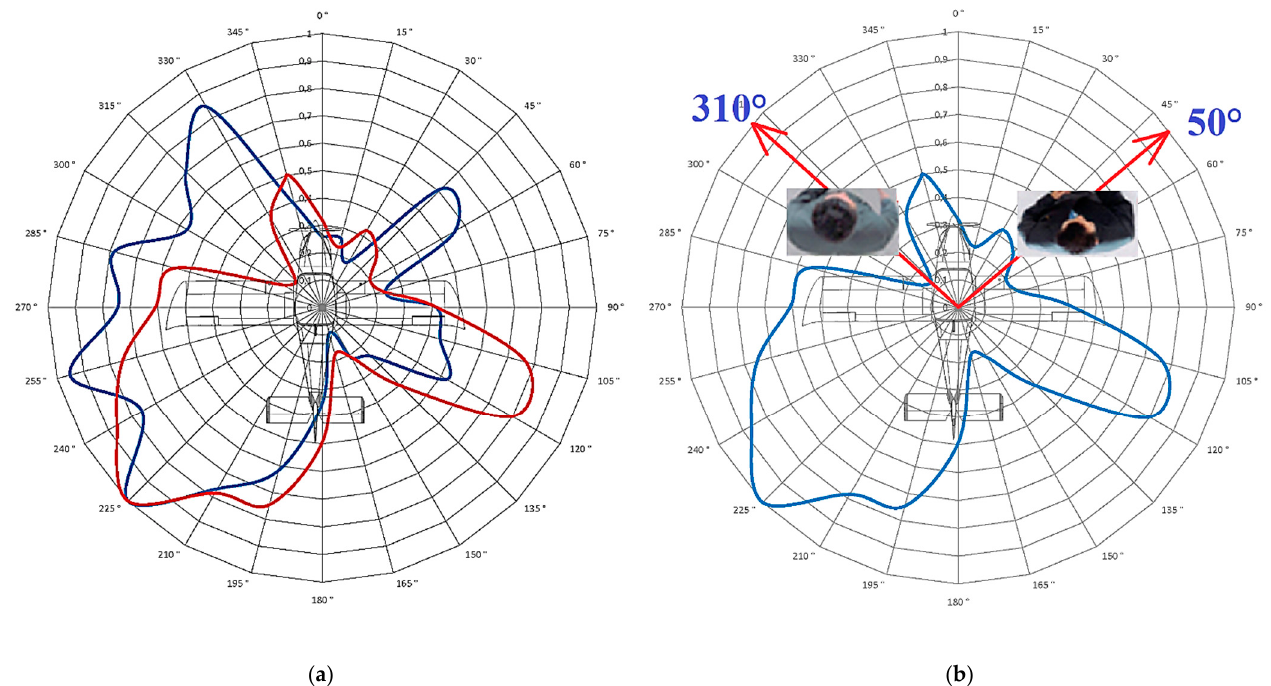
Figure 13. Measurement of the aircraft antenna characteristic at a position angle θ of 30°: ( a ) polar characteristics of the antenna; ( b ) spatial illustration of the measurement.